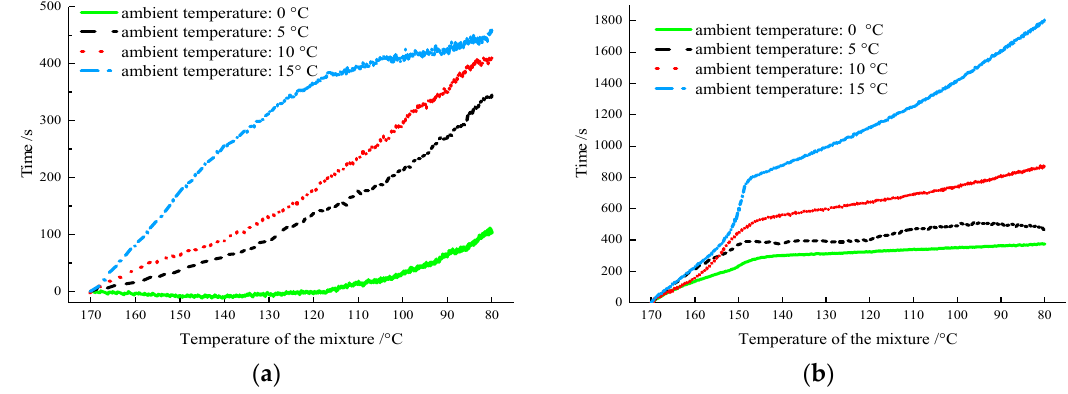
Figure 7. Change in the thermal-insulation extension time during the cooling processes of the two samples: ( a ) edge; ( b ) center.